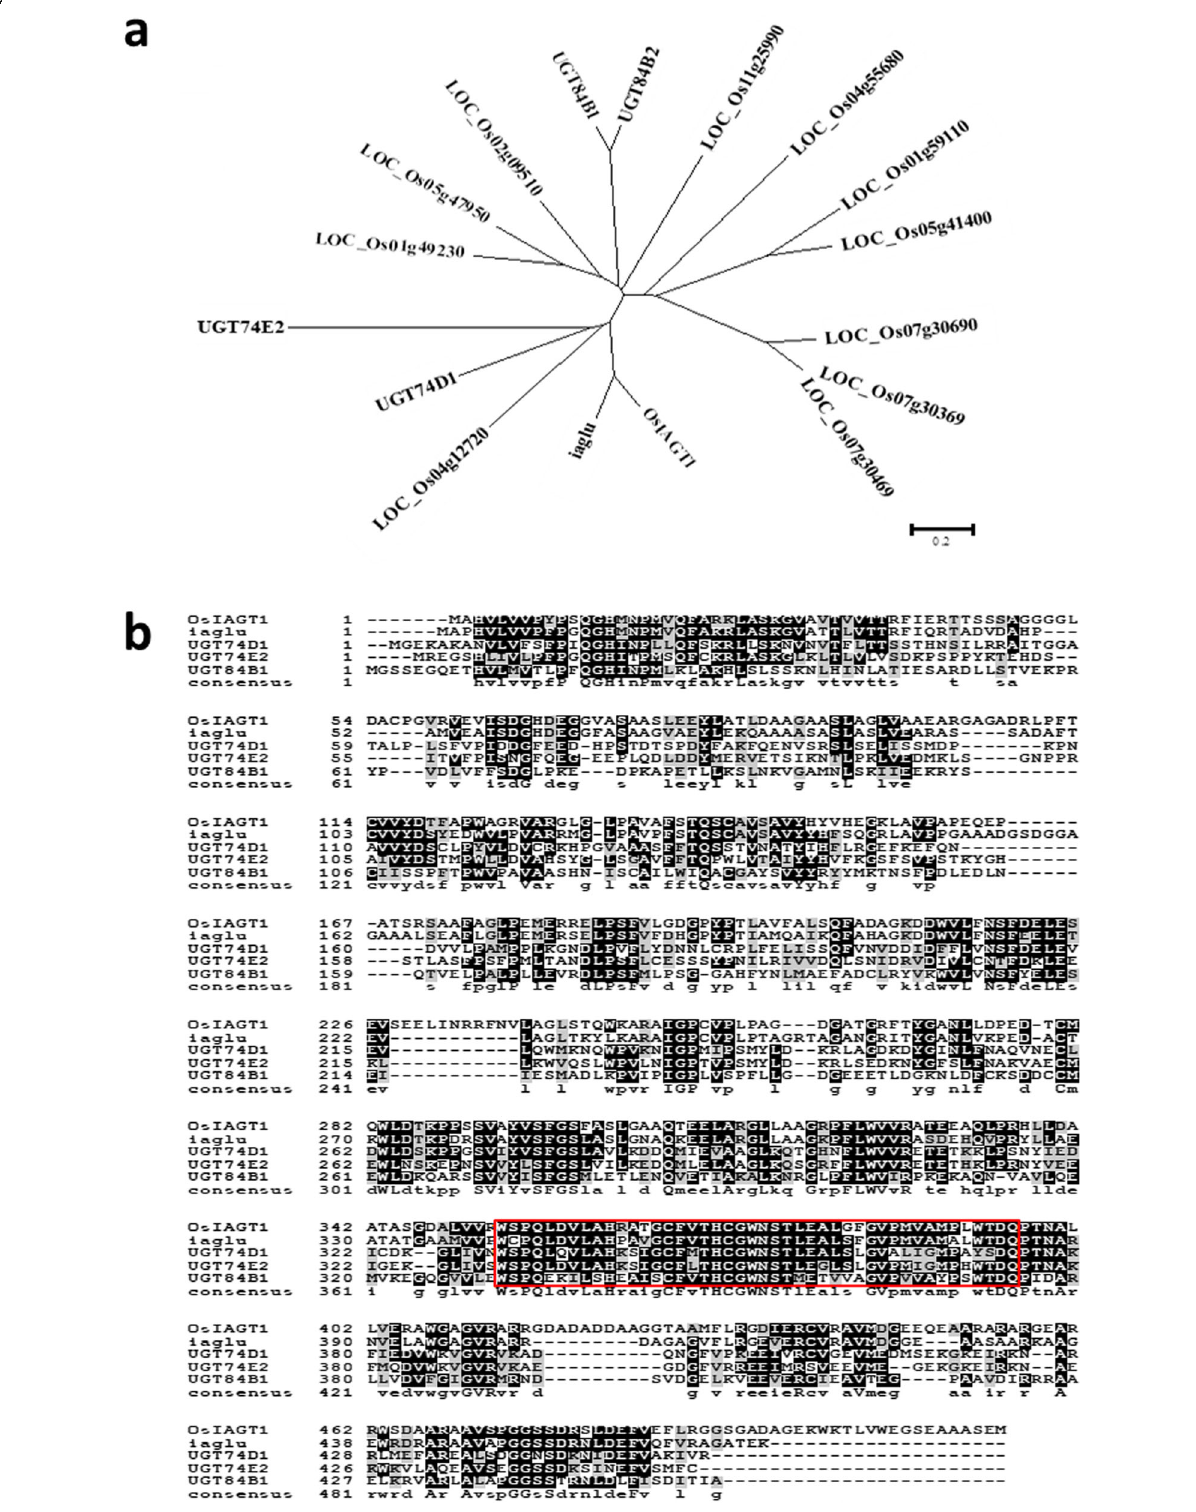
Fig. 1 Phylogenetic analysis of OsIAGT1. a Phylogenetic analysis of 12 rice genes and other auxin UGTs from maize and Arabidopsis. Rice LOC_Os03g48740 is named OsIAGT1. b Alignment of amino acid sequence of OsIAGT1 with other auxin UGTs from maize and Arabidopsis. The C-terminal conserved glycosyltransferase PSPG domain was shown in red